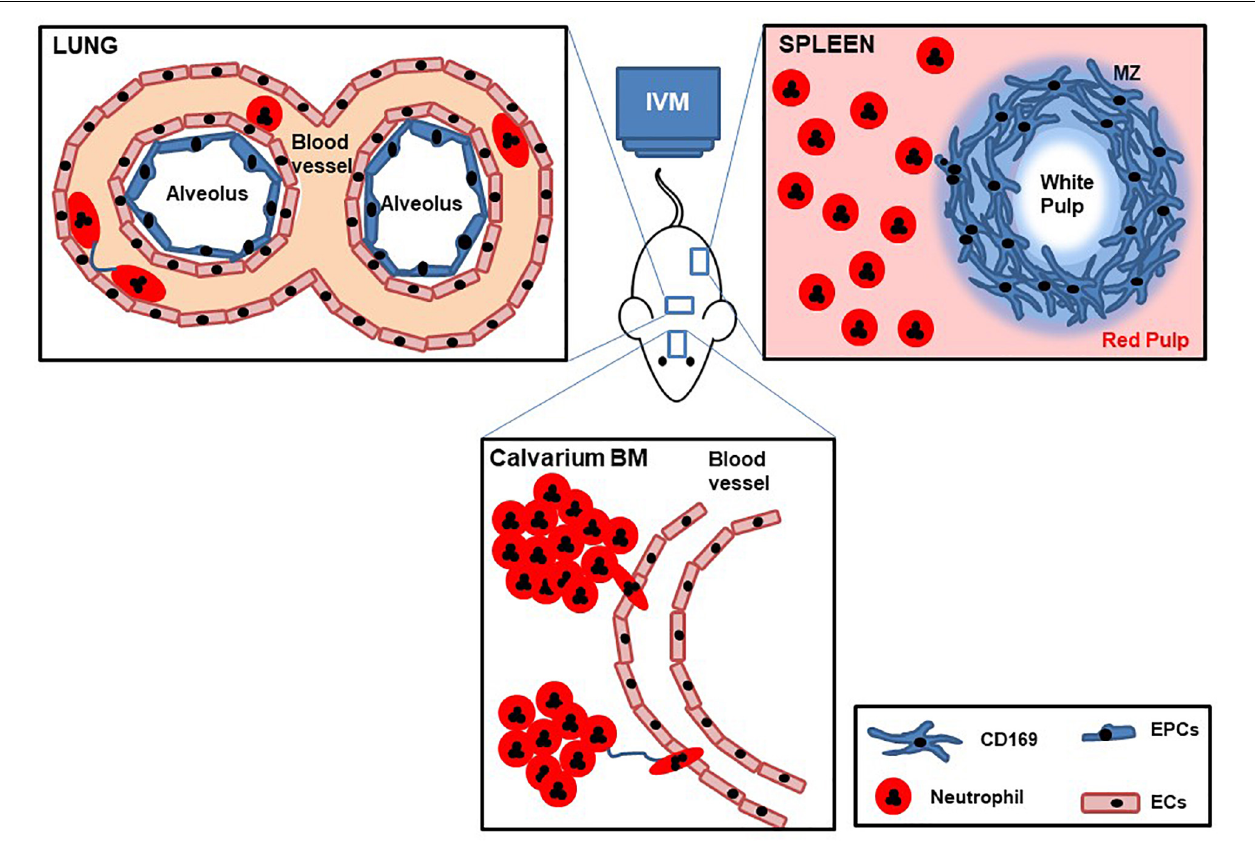
FIGURE 3 | Cartoon with schematic representation of lung, spleen, and calvarium BM IVM. Mice are deeply anesthetized, fluorescent Abs are intravenously injected, and internal organs are partially exposed to be imaged by IVM while maintaining blood flow. Dynamic behaviors of tissue neutrophil motility, cell–cell interactions, and temporal change in speed are recorded over